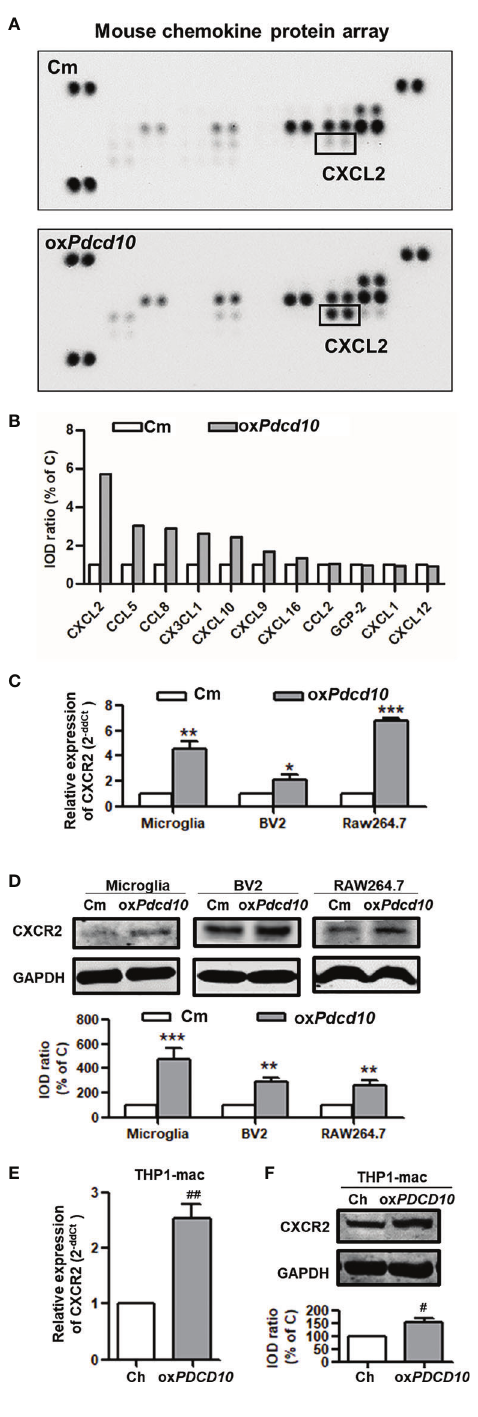
FIGURE 5 | Upregulation of Pdcd10 in murine GBM cells triggered the release of CXCL2 that in turn activated CXCR2 on microglia and macrophages. (A) Different expression of various chemokines in media derived from Pdcd10 -overexpressed or control-GL261 cells (ox Pdcd10 or C) was detected by a mouse chemokine array kit. (B) Semi-quanti fi cation of the dot-blots. CXCL2 was demonstrated as a nearly 6-fold increase in ox Pdcd10 -medium than that in control medium. (C, D) Detection of CXCR2 in murine BV2, RAW264.7 and primary microglia. (C) RT 2 -PCR and (D) Western blot demonstrated that CXCR2 was upregulated in murine primary microglia, BV2 and RAW264.7 in ox Pdcd10 -group. (E, F) CXCR2 in human THP1-mac cells was detected at mRNA (E) and protein levels (F) . *p < 0.05, **p < 0.01 and ***p < 0.001, compared with Cm. # p < 0.05 and ## p < 0.01, compared with